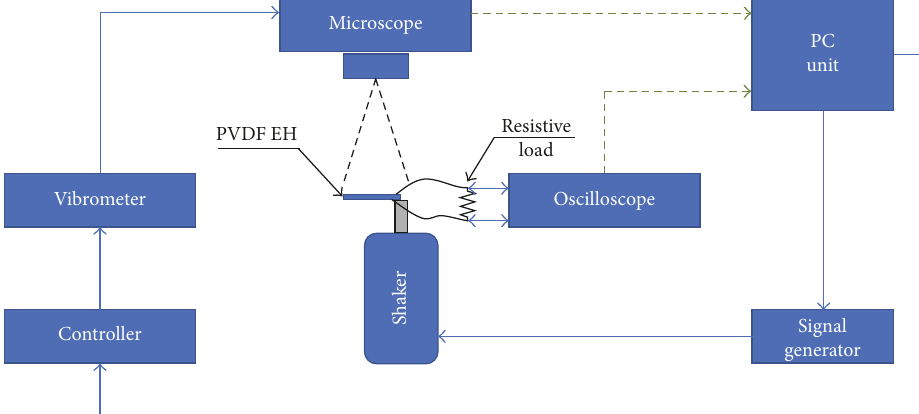
Figure 17: Block diagram of the experimental